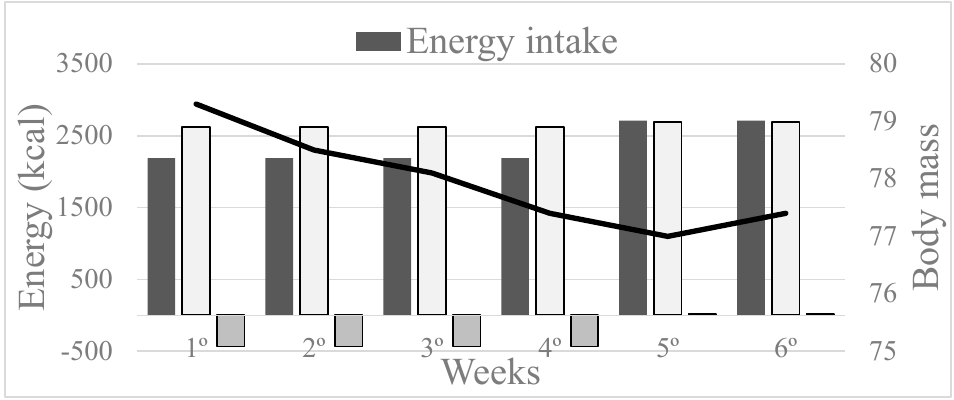
Figure 1. Energy intake, energy expenditure, energy balance, and their relationship with body mass for 6 weeks.